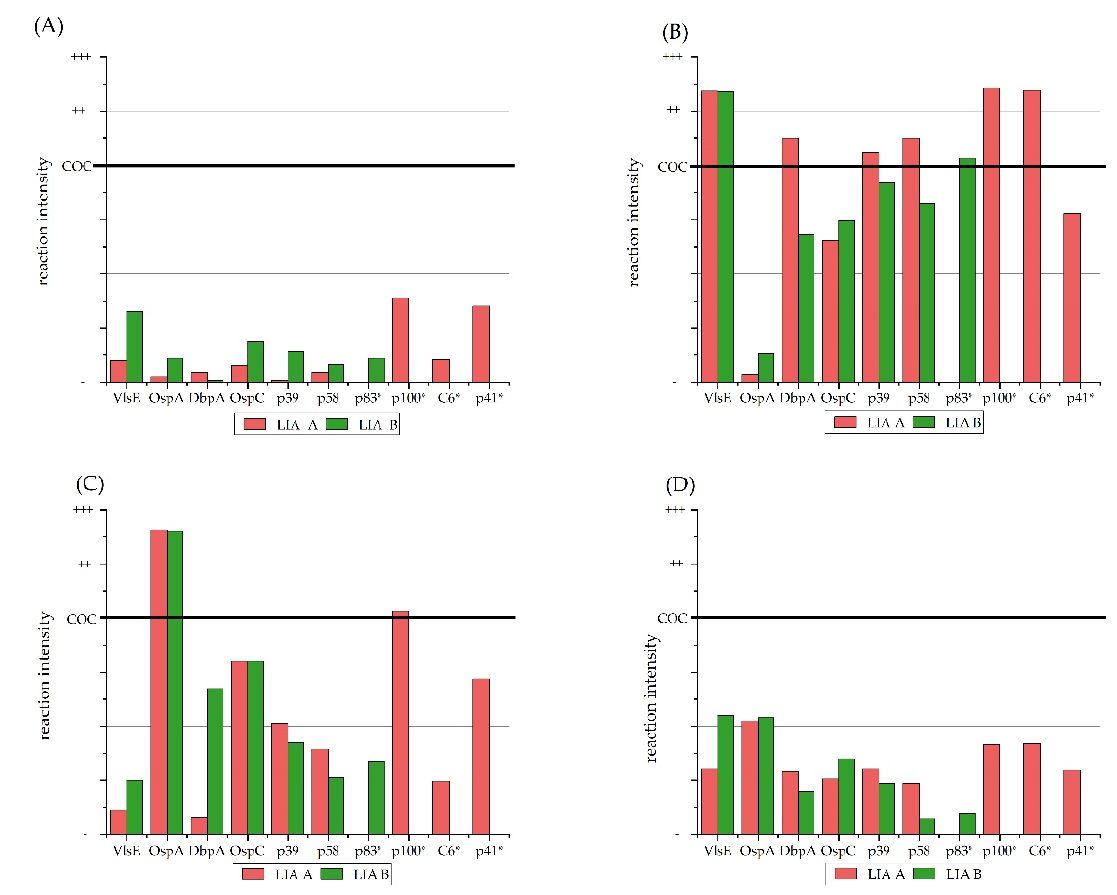
Figure 1. Degree of antigen-antibody reactions on LIA A and LIA B resulting from testing with canine serum samples. Ranking from reaction as “ − “, less than the cut-off control COC; “+”, equal to the COC; “++”, strong; and “+++”, very strong reactions. Antigens marked with * are unique for the respective LIA. Degree of antigen-antibody reactions of sera ( A ) from group “negative”; ( B ) from group “positive”; ( C ) from group “vaccinated”; ( D ) from group “control sera”. COC, cut-off control; VlsE, variable major protein-like sequence expressed; OspA, outer surface Protein A; DbpA, decorin binding protein A; OspC, outer surface protein C; BmpA, borrelia membrane protein A; p, protein; C 6 , C 6